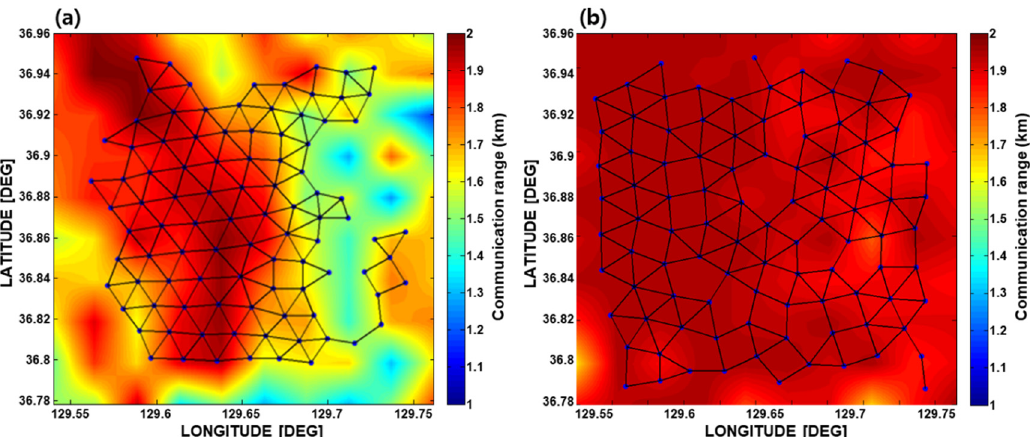
Figure 6. Results of the optimal deployment simulation using two different sensor node types: ( a ) the three-channel vertical-pressure sensor array, and ( b ) the single-vector sensor. The solid lines between the sensor nodes indicate their connectivity, which was estimated by comparing the communication range of each sensor node with the range from each sensor node to its neighboring nodes. In both cases, every sensor node was 100% connected.